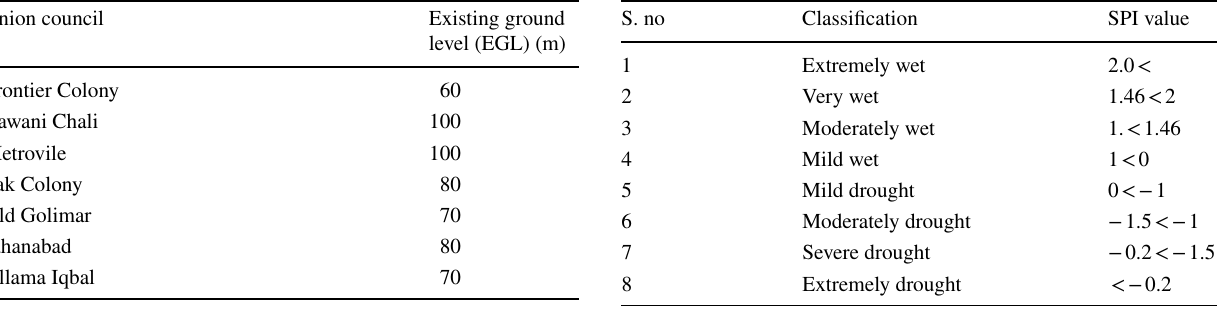
Table 7 Climatic trend analysis table (Tigkas et al.